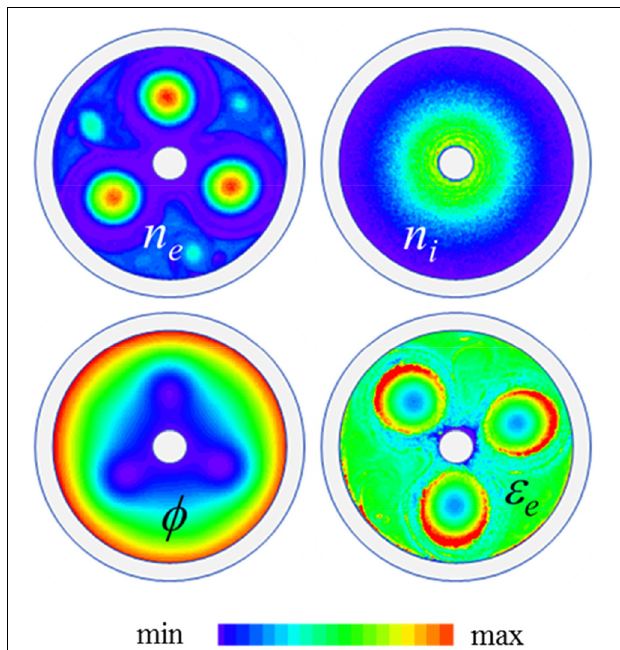
FIGURE 3 | Distributions of the electron density, n e , ion density, n i , electric potential φ , and electron mean energy ε e at a given time in a cylindrical magnetron (cathode and anode diameters 1 and 6cm respectively); argon at 0.05mTorr, applied voltage 2kV, magnetic field 50mT. The magnetron length is 10cm and the end plates are biased at − 100V with respect to the cathode. The plots are linear, in the (min, max) ranges (0, 3 × 10 15 m − 3 ) for n e , (0, 0 . 2 × 10 15 m − 3 ) for n i , ( − 60, 2000V) for φ , (0, 120eV) for ε e . The period of rotation of the structure is about 70ns, on the order of E / B at the vortex